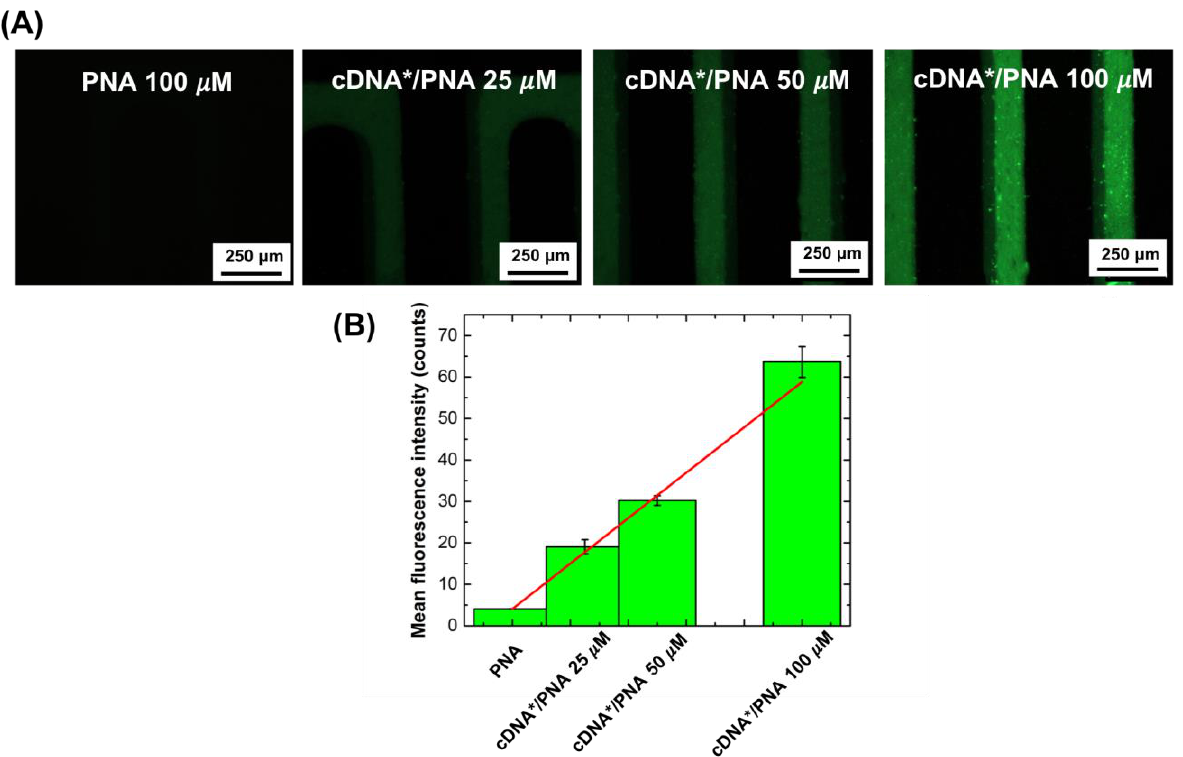
Figure 6. ( A ) Fluorescence microscopy imaging of ZnONW biochip surface after functionalization with 100 µM PNA probe and after incubation with 25, 50, and 100 µM cDNA* . ( B ) Mean fluorescence intensity, calculated from the images in (A), as a function of cDNA* concentration. Data were fitted using a linear regression model (red line).